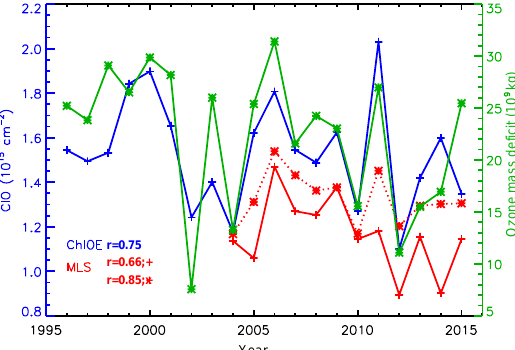
Figure 5. The climatology plus annual average anomaly (1) day minus night ClO column density for 28 August to 17 September of each year, calculated as described in text. Averages are shown for ChlOE at Scott Base (blue), MLS coincident with Scott Base (solid red), and MLS at the latitude of Scott Base (dashed red line). Also shown is the ozone mass deficit in 10 9 kg of ozone relative to the 220DU value (green line, with right-hand axis). The correlation co- efficients between the ClO measurements and the ozone mass deficit are